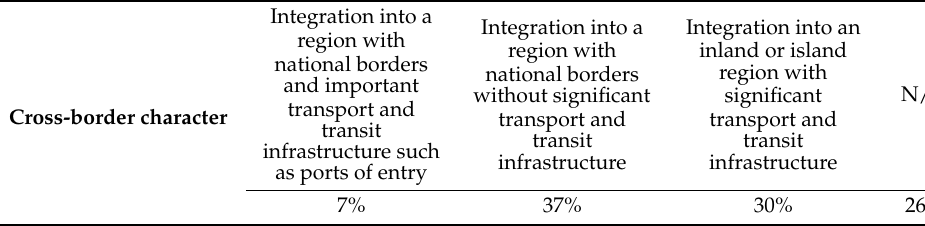
Table 4. Interregional analysis (%) of 27 organized